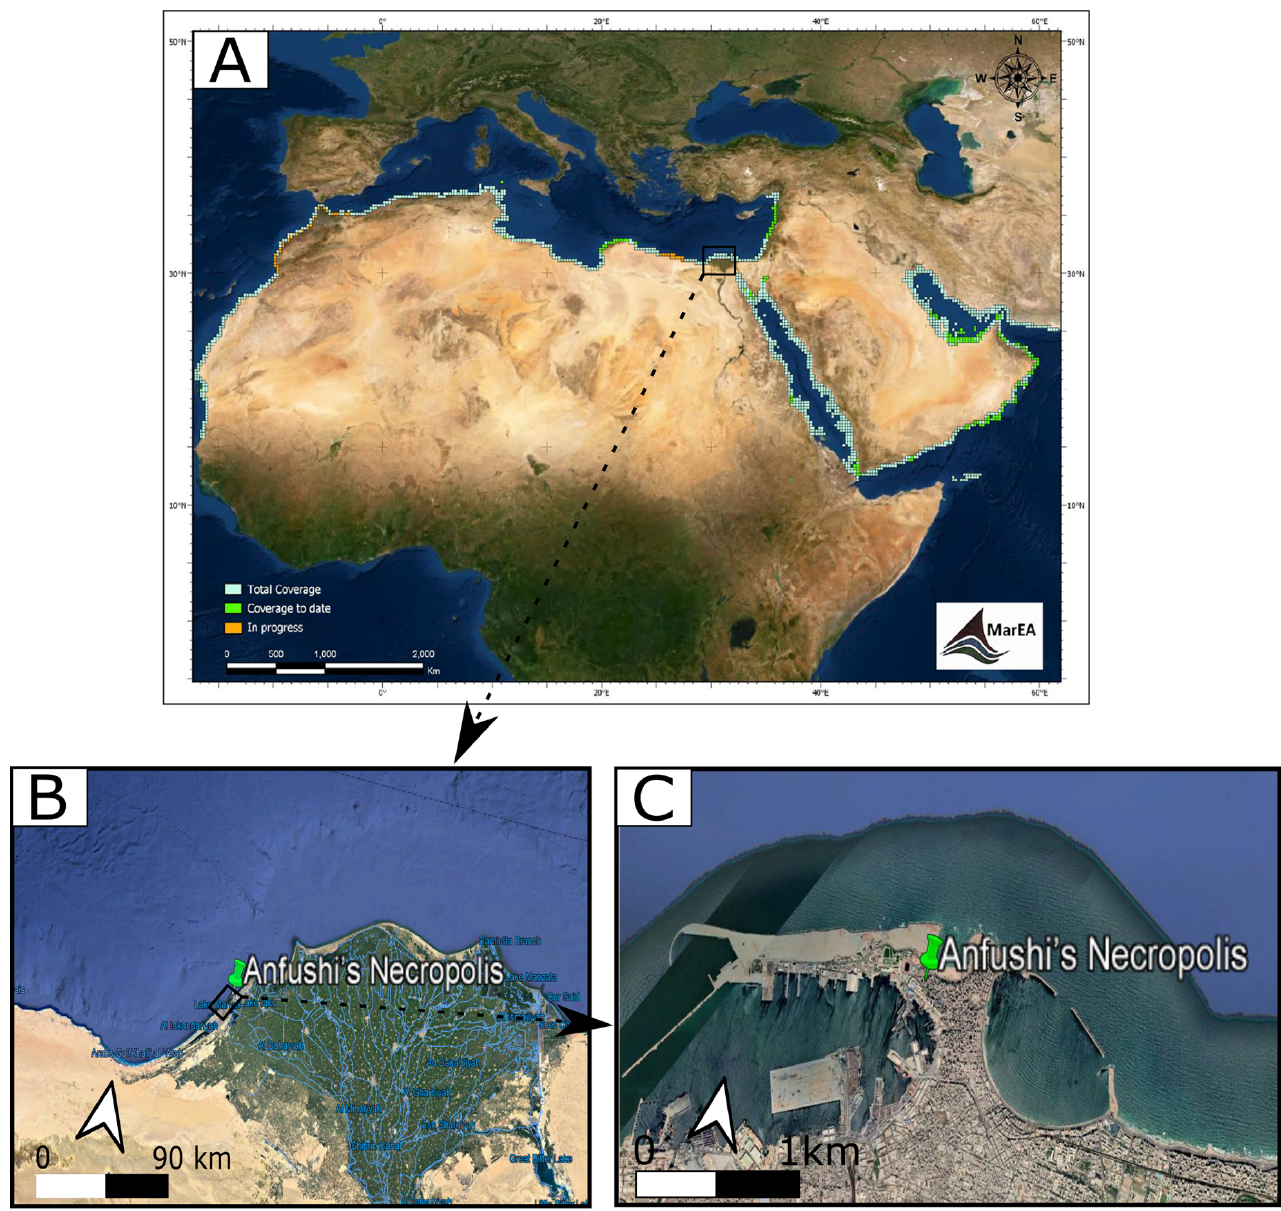
Figure 2. ( A ) General map of the endangered coastal archaeological sites in North Africa and the Middle East. From [17]. ( B ) Zoomed-in risk map of the delta (including Alexandria), and the green pin shows the case study of Anfushi’s Necropolis as an endangered coastal archaeological site in North Africa, Egypt (Alexandria). ( C ) Zoomed-in map of endangered Anfushi’s Necropolis and its surrounding coastal